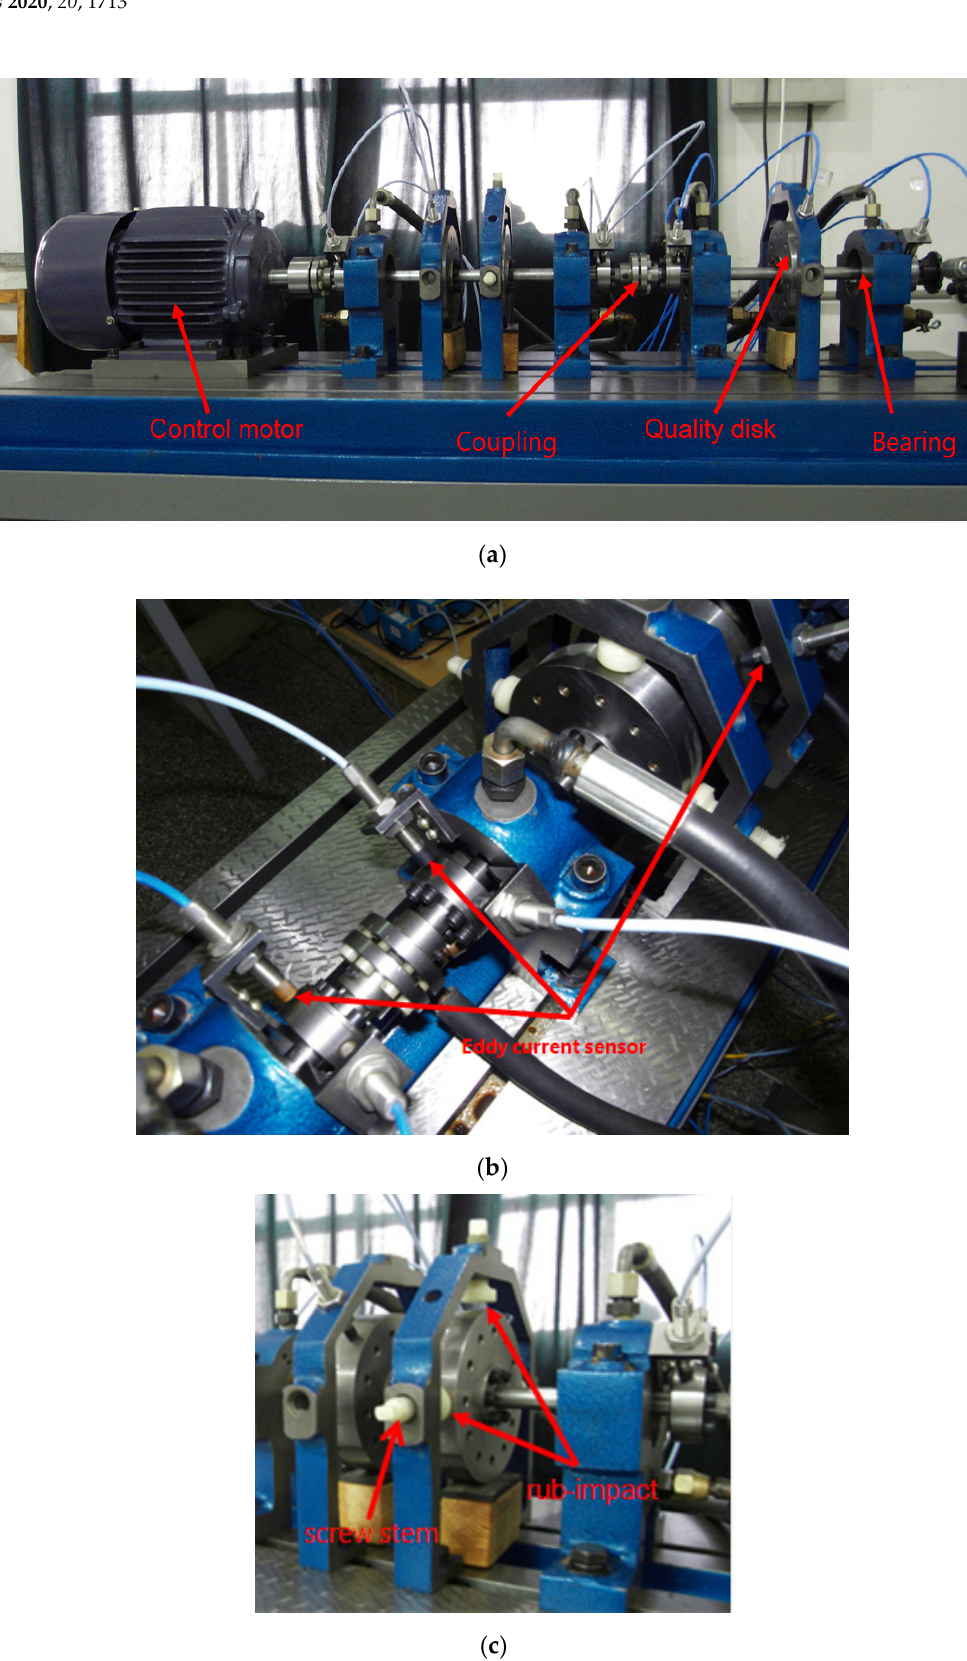
Figure 3. The two-span rotor-bearing rig. ( a ) The rotor testbed. ( b ) Installation positions of sensors. ( c ) Rotor rub test.